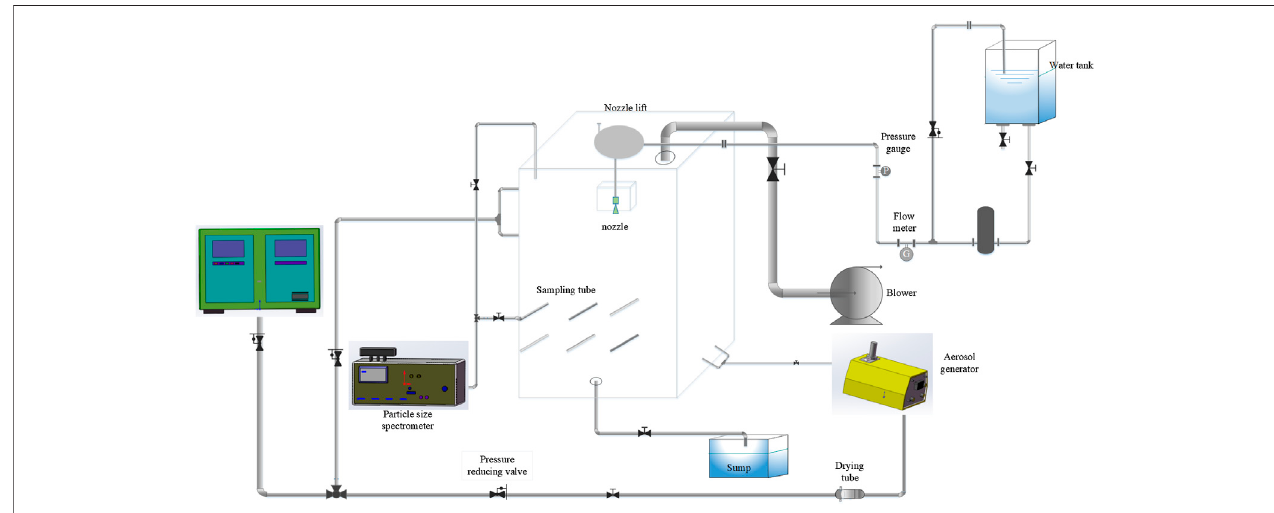
FIGURE 1 | Experimental facility.